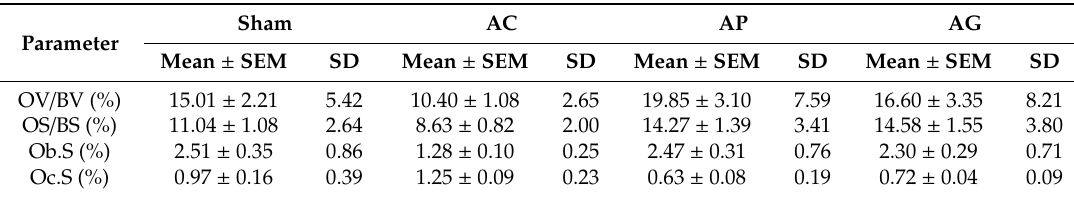
Table 2. Mean values, standard error of mean (SEM), and standard deviation (SD) of static histomorphometric parameters.